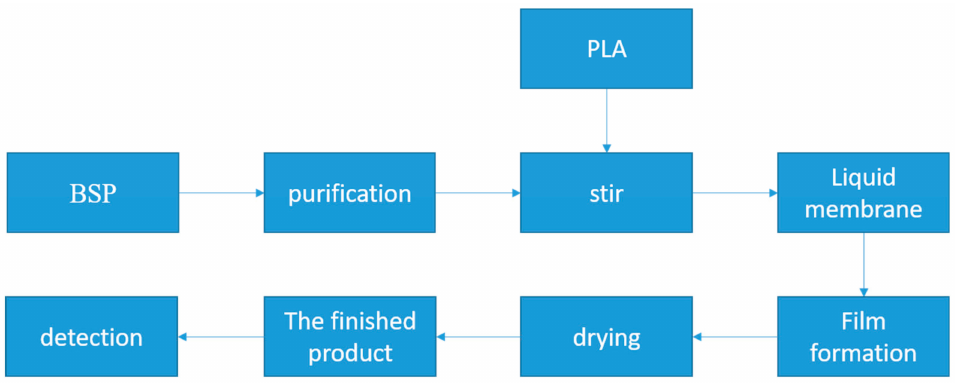
Figure 8. Membrane